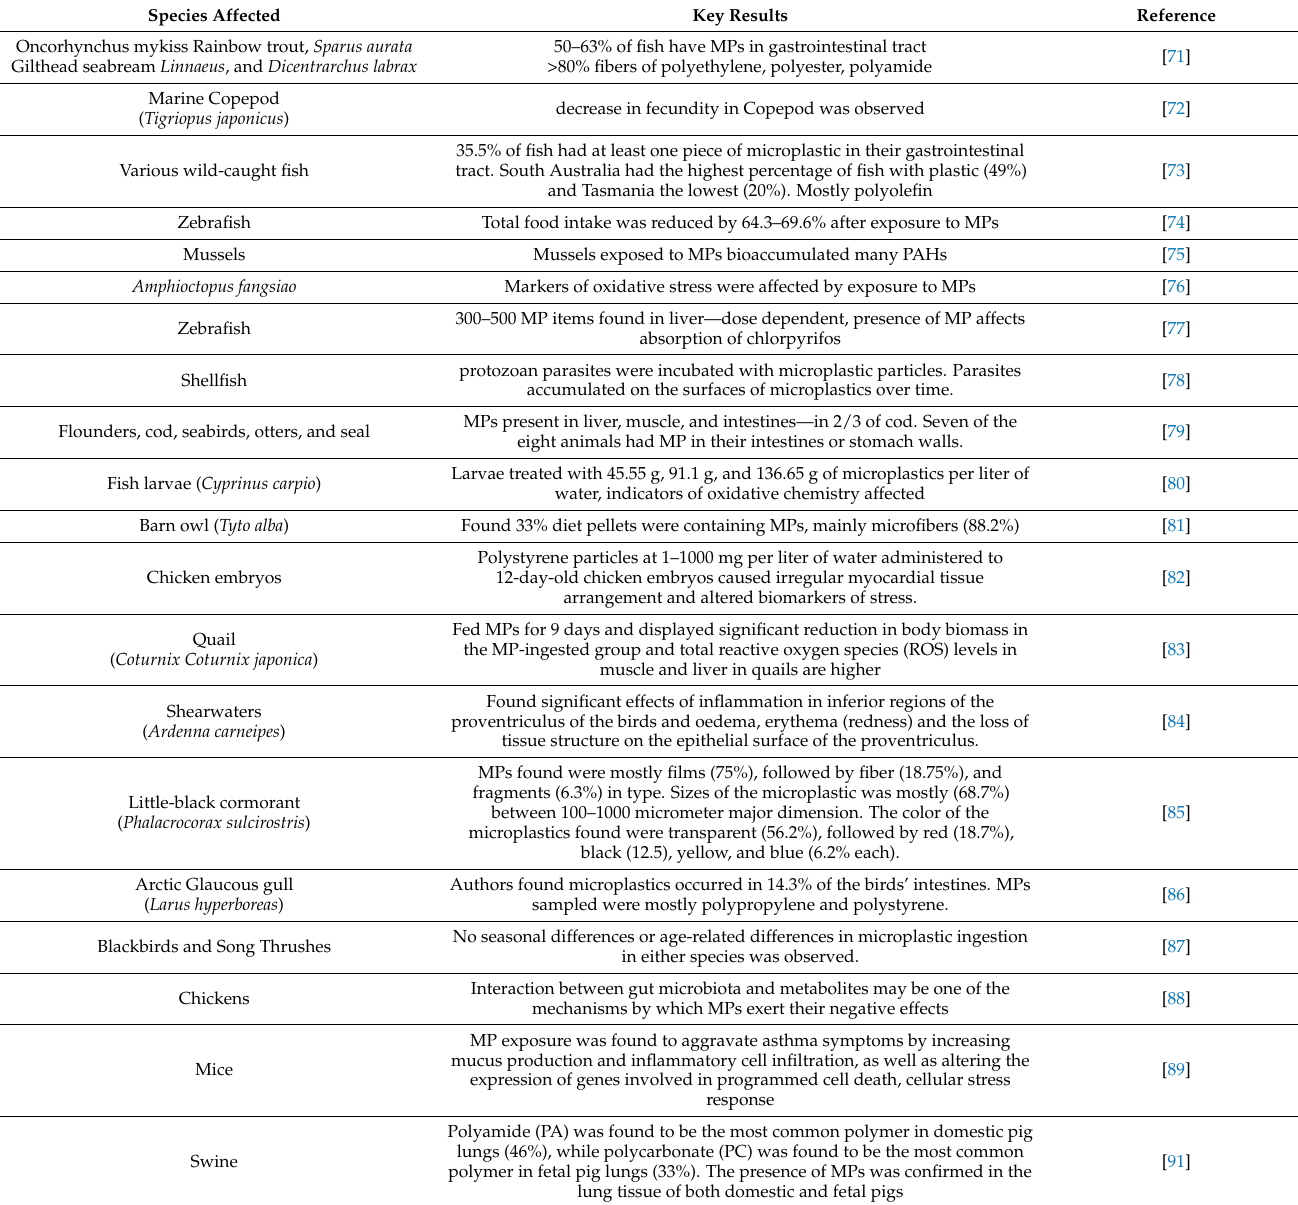
Table 2. Summary of studies involving MPs and